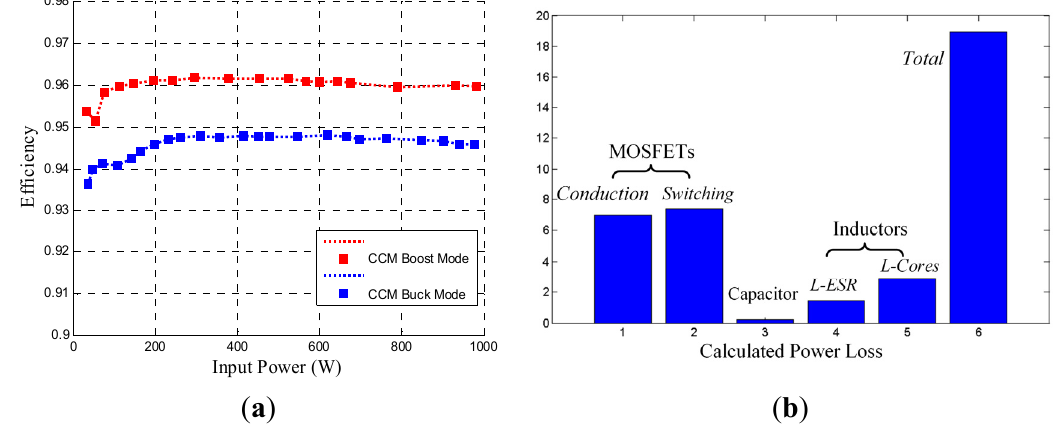
Figure 21. ( a ) Measured efficiency. ( b ) Calculated losses